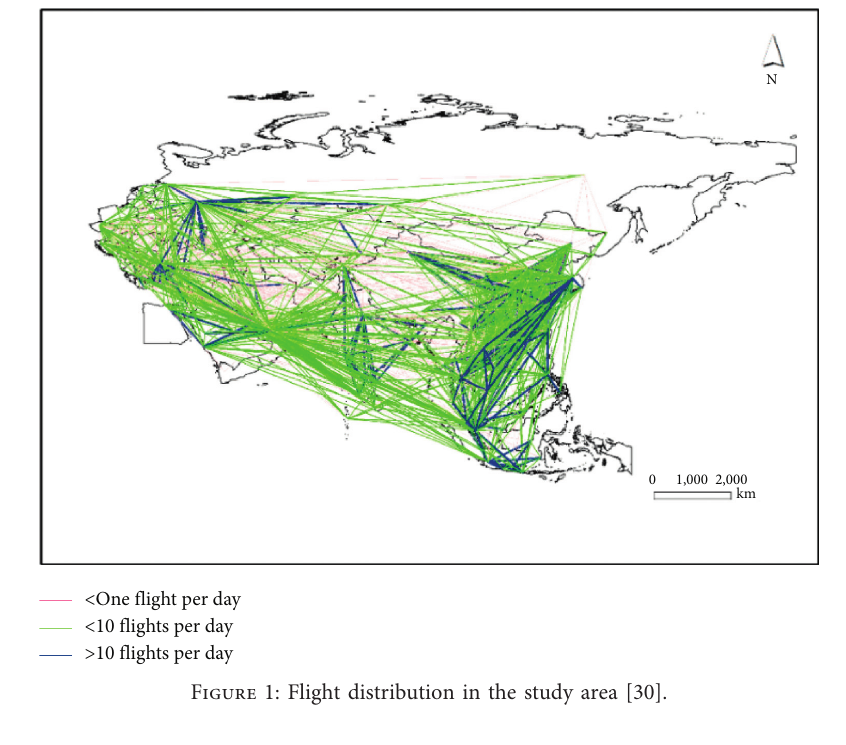
Figure 1: Flight distribution in the study area